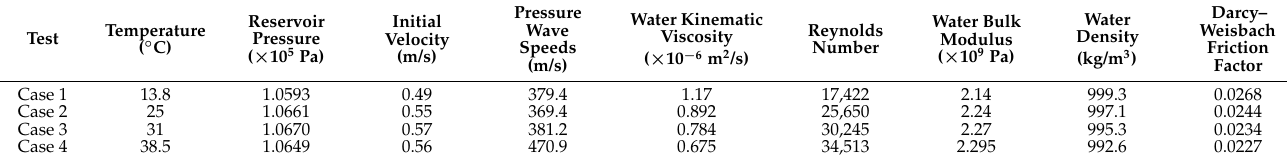
Figure 3. Schematic diagram of the experimental setup [29]. Table 1. Experimental data for different cases